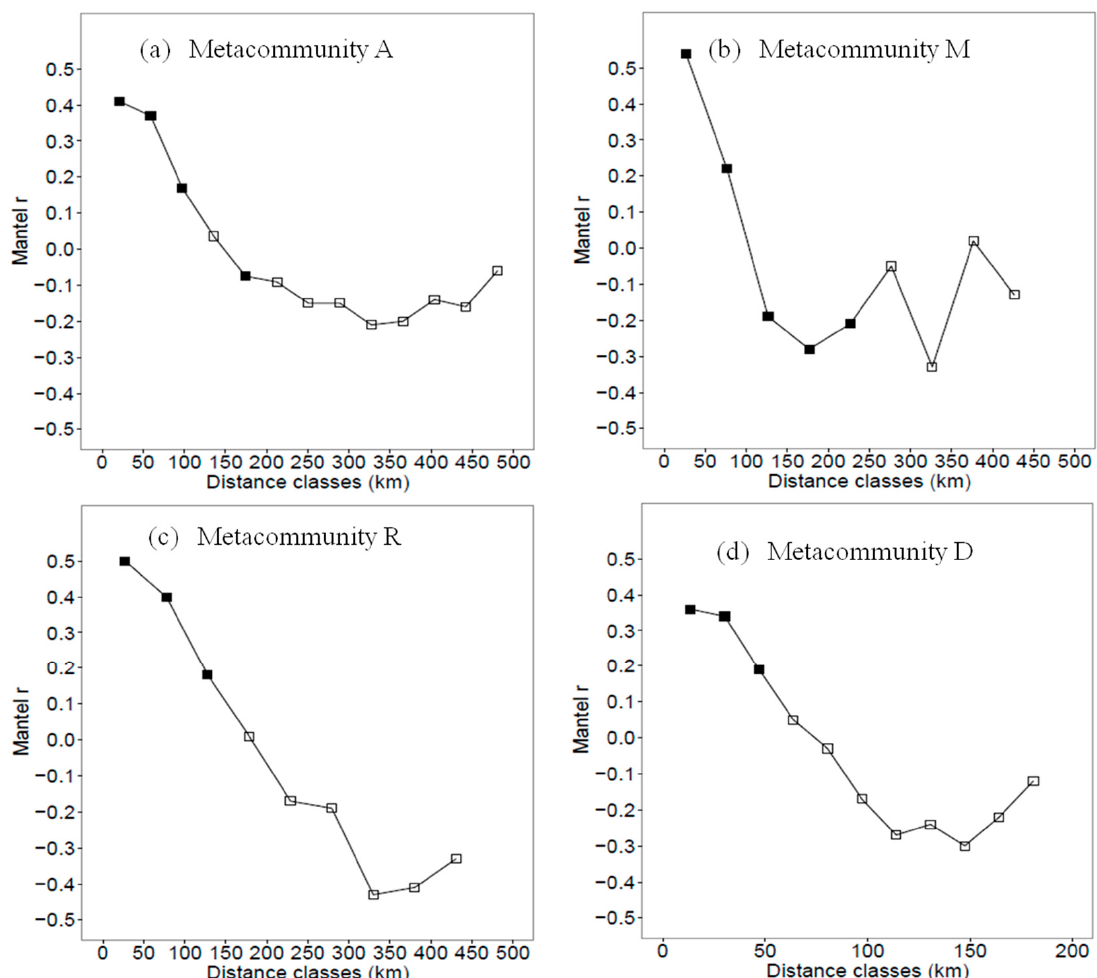
Figure 3. Mantel correlograms for environmental predictors in ( a ) metacommunity A (localities in the study area), ( b ) metacommunity M (localities in the mountain landscape), ( c ) metacommunity R (localities in the riparian landscape) and ( d ) metacommunity D (localities in the desert landscape). Solid squares indicate that the correlations are significant at a = 0.05, and the blank squares indicate that the correlations are not significant.